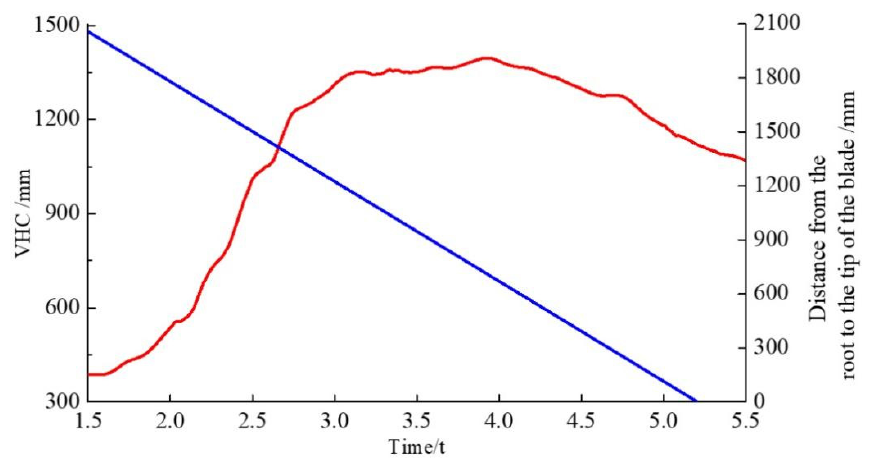
Figure 6. Stalk lifting and cutting point motion analysis.